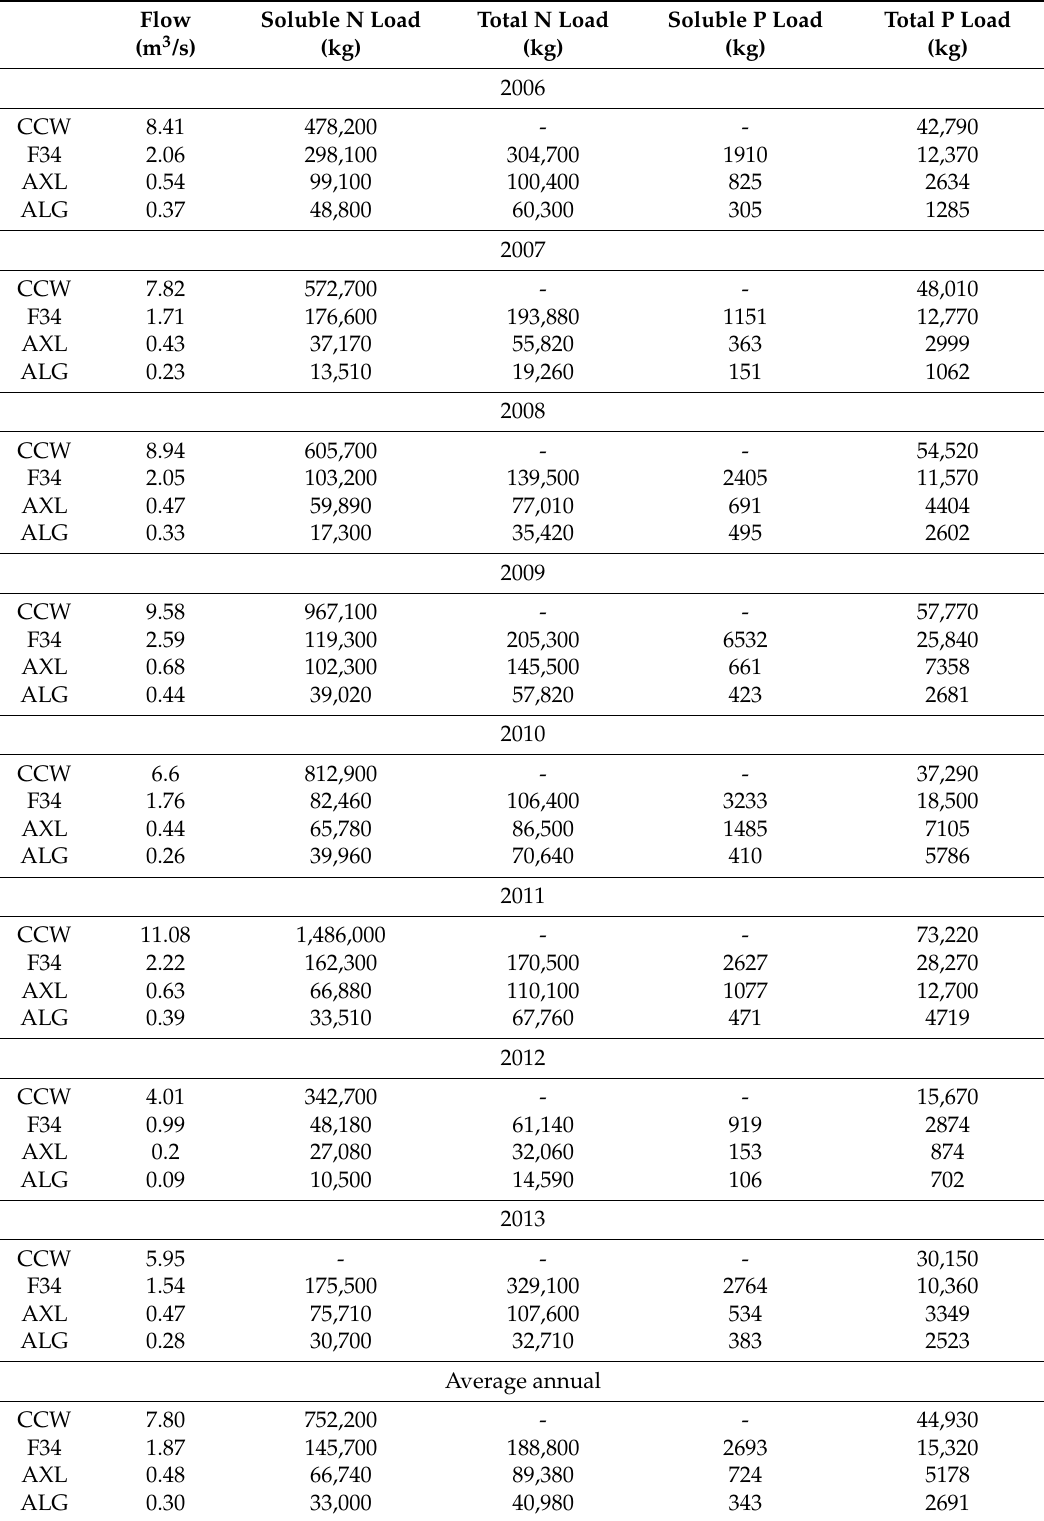
Table 6. Annual streamflow rates and nutrient loads measured from each watershed for